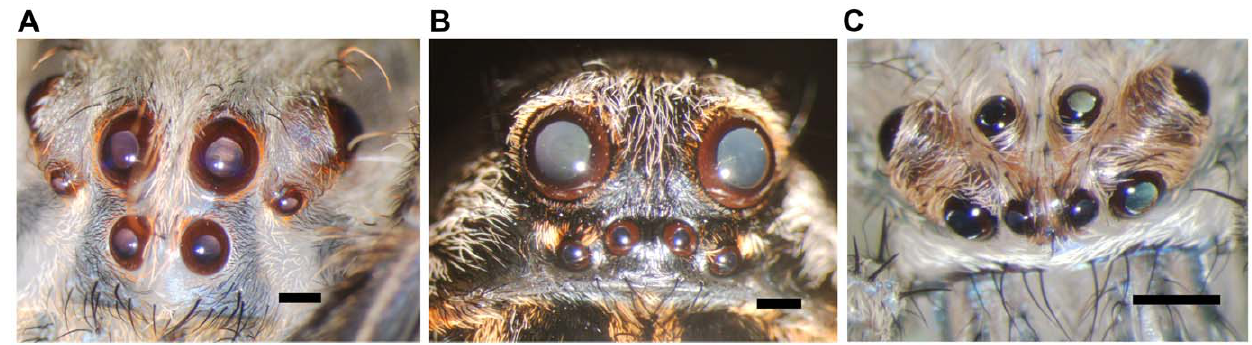
Figure 2. Photographs of freshly molted spiders. Portraits of Cupiennius salei (A), Lycosa tarentula (B) and Heteropoda venatoria (C) the day after ecdysis. In all three species the iris formed by the pigment ring is clearly visible and was observed to disappear in the days thereafter. Scale bars: